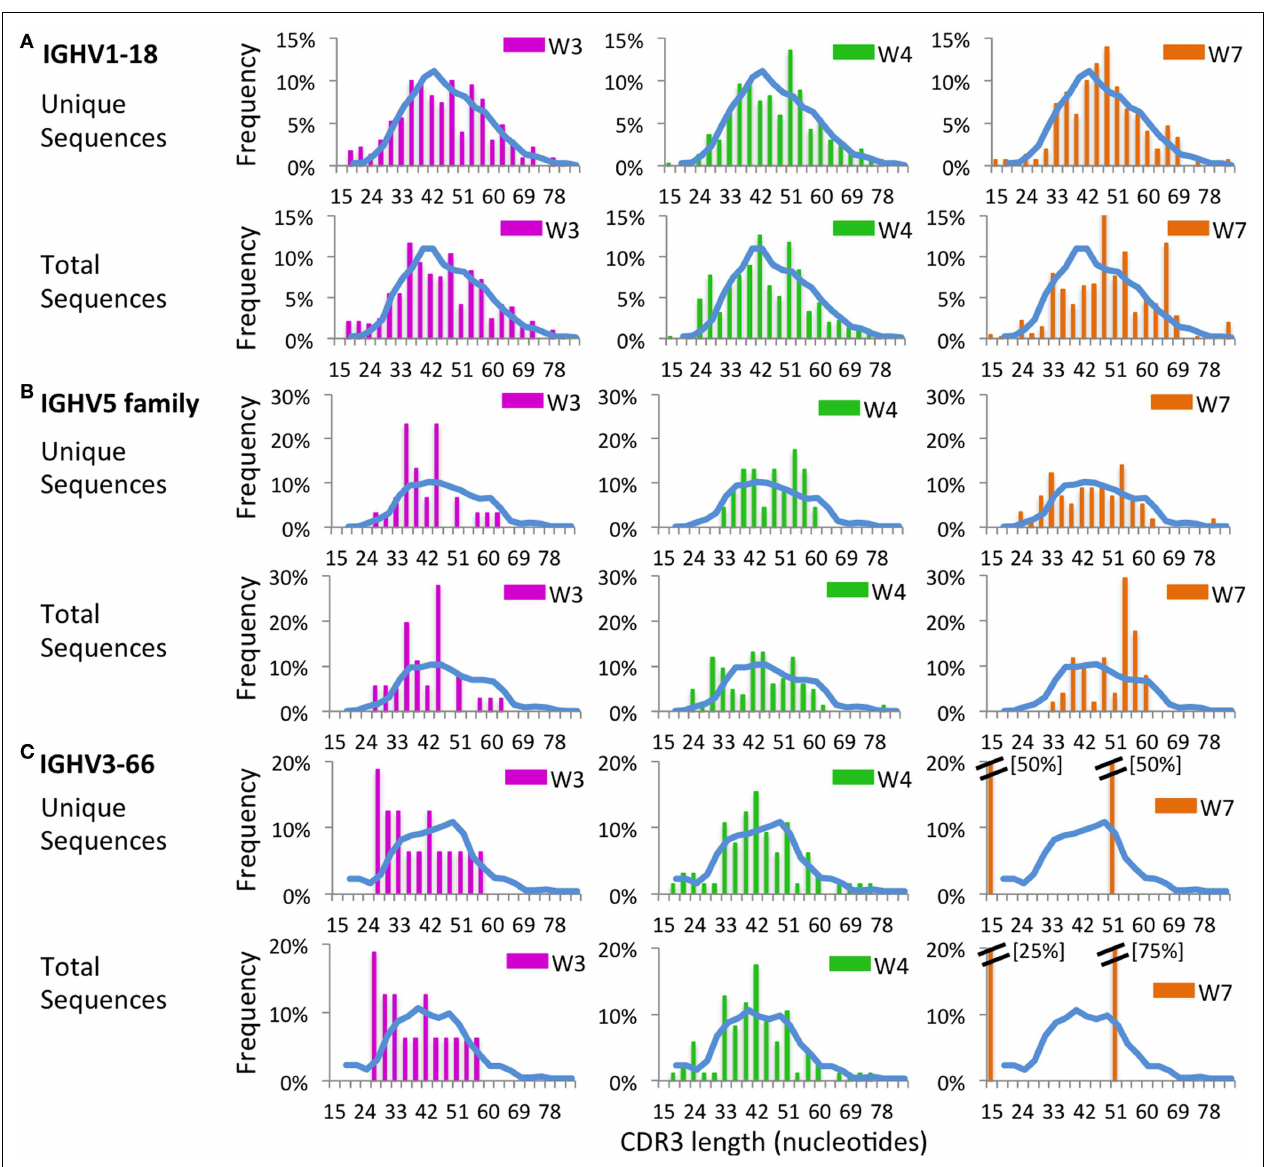
of controls (C1 and C2) is displayed as a blue bar. A double bar indicates the value of the bar has exceeded the axis limit, and the maximum value is indicated within